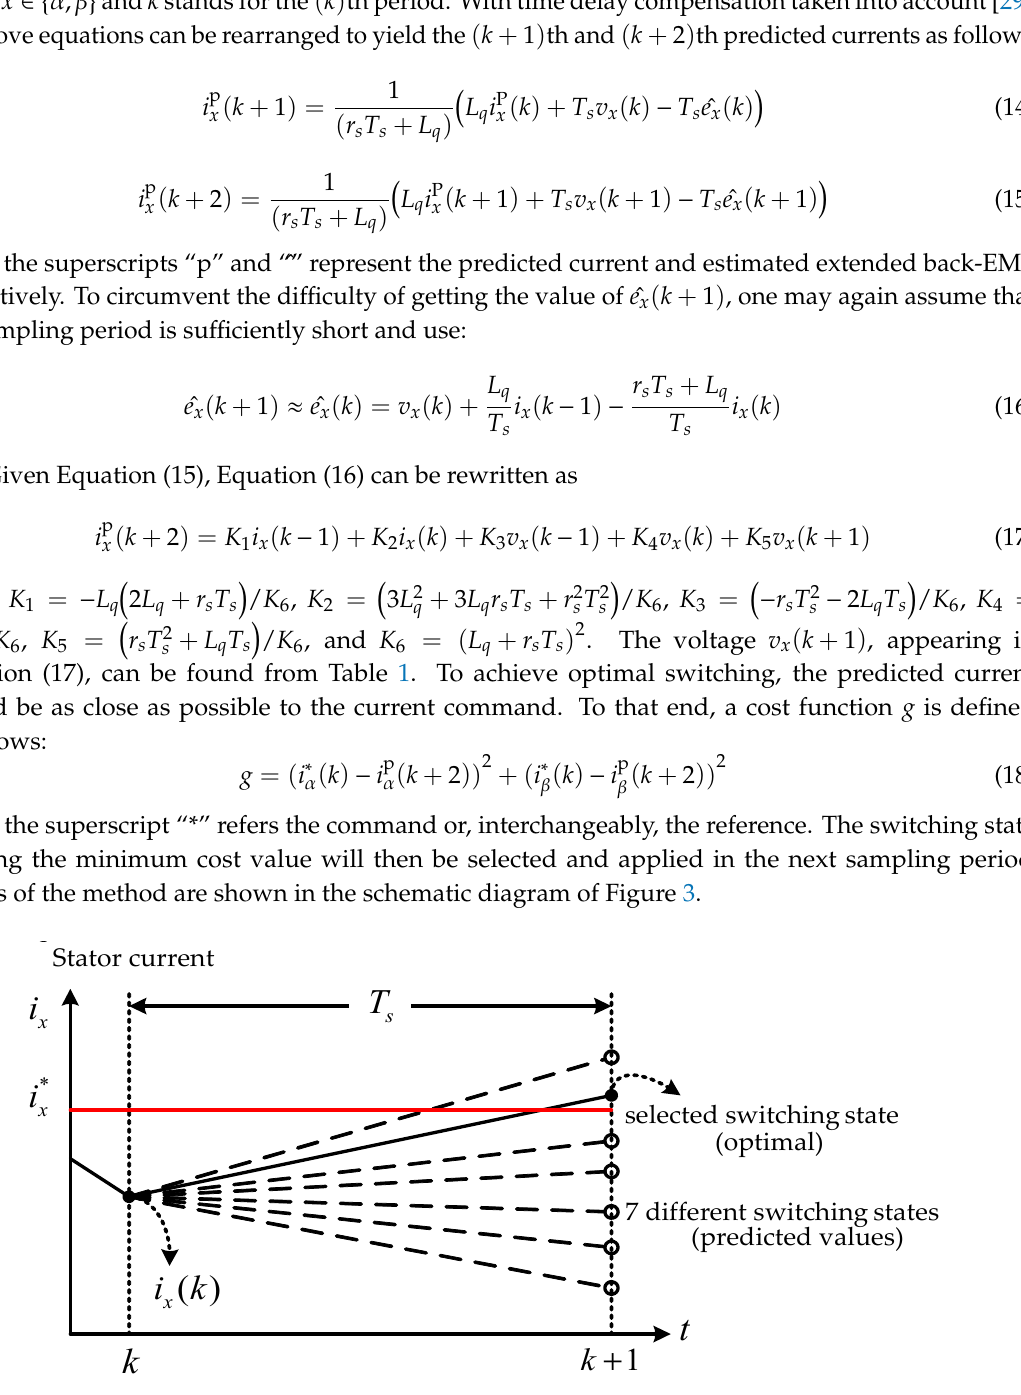
Figure 3. Current prediction control of conventional MPC.